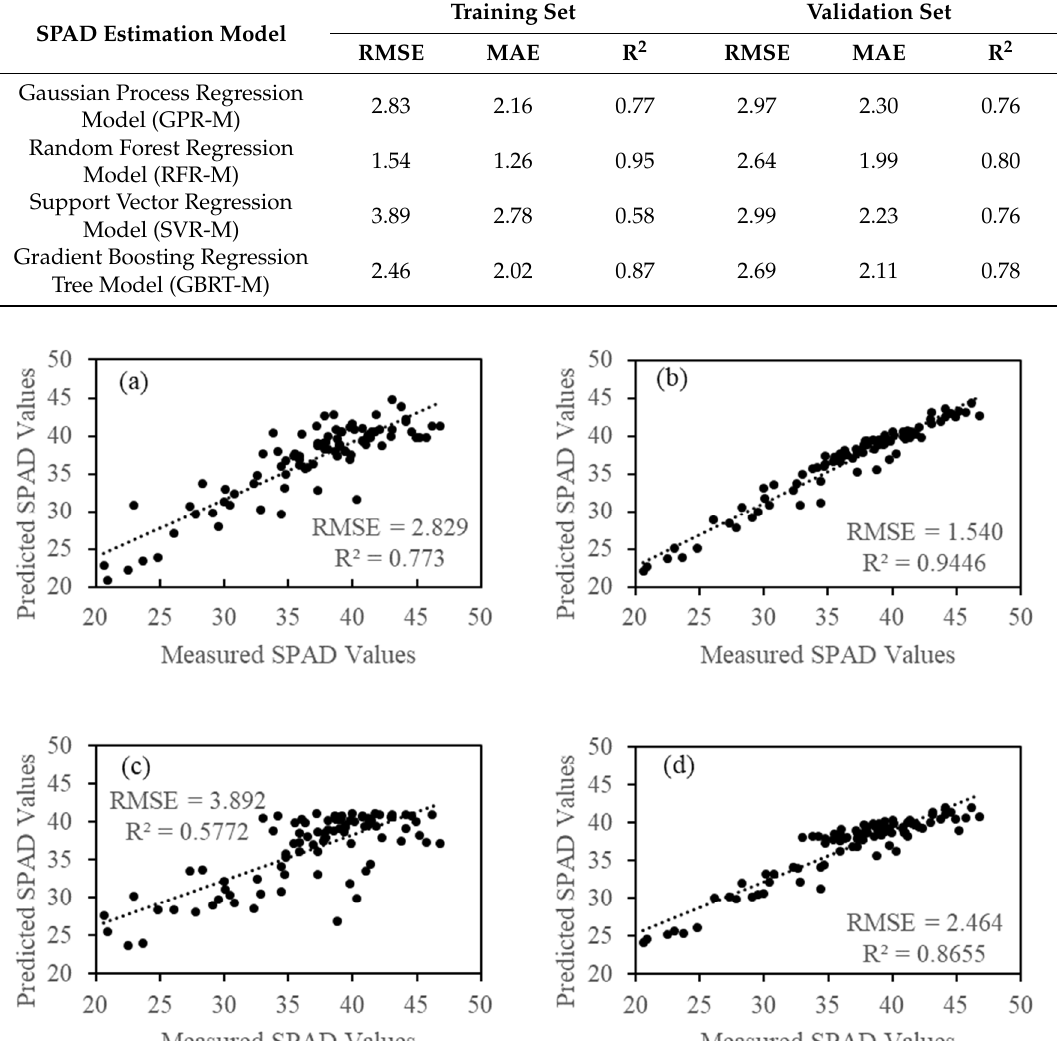
Figure 16. Scatterplots between the measured SPAD value and the predicted SPAD value using the validation set. Note: ( a ) GPR-M; ( b ) RFR-M; ( c ) SVR-M; ( d ) GBRT-M.